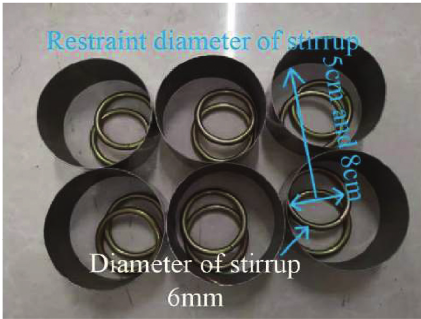
Figure 3: Steel pipe and stirrups specimen.